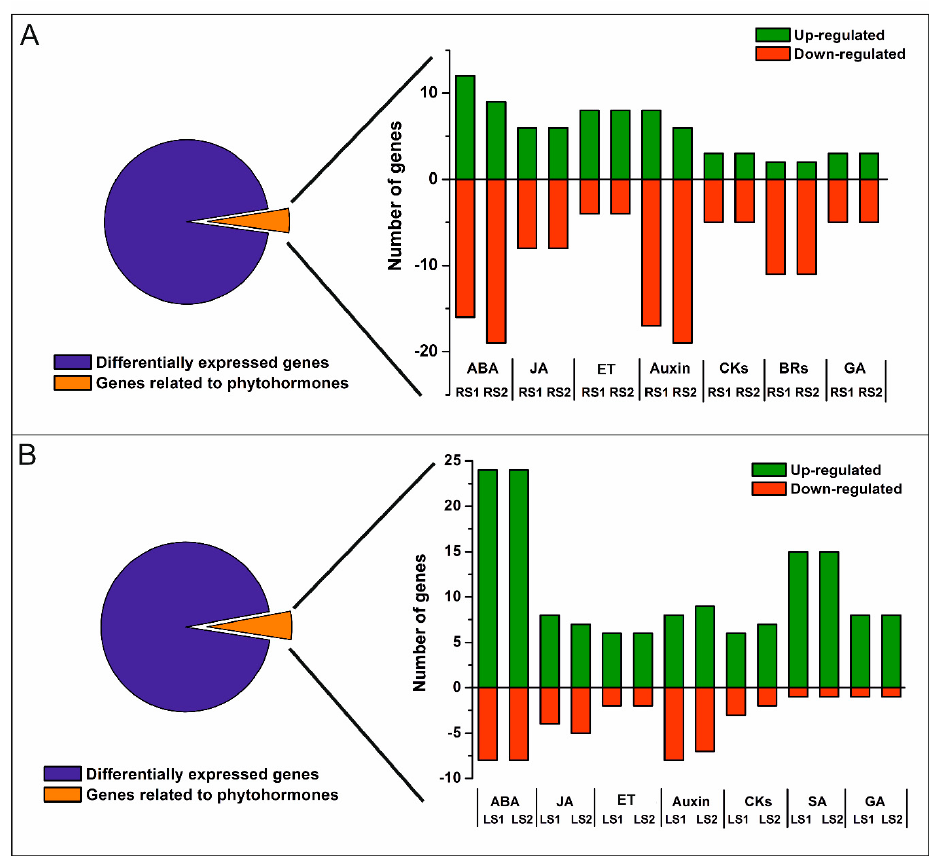
Figure 3. Number of up- and down-regulated phytohormone-related genes in roots ( A ) and leaves ( B ). Abbreviations: ABA, abscisic acid; JA, jasmonic acid; ET, ethylene; CKs, cytokinins; BRs, brassinosteroids; SA, salicylic acid; GA, gibberellic acid.